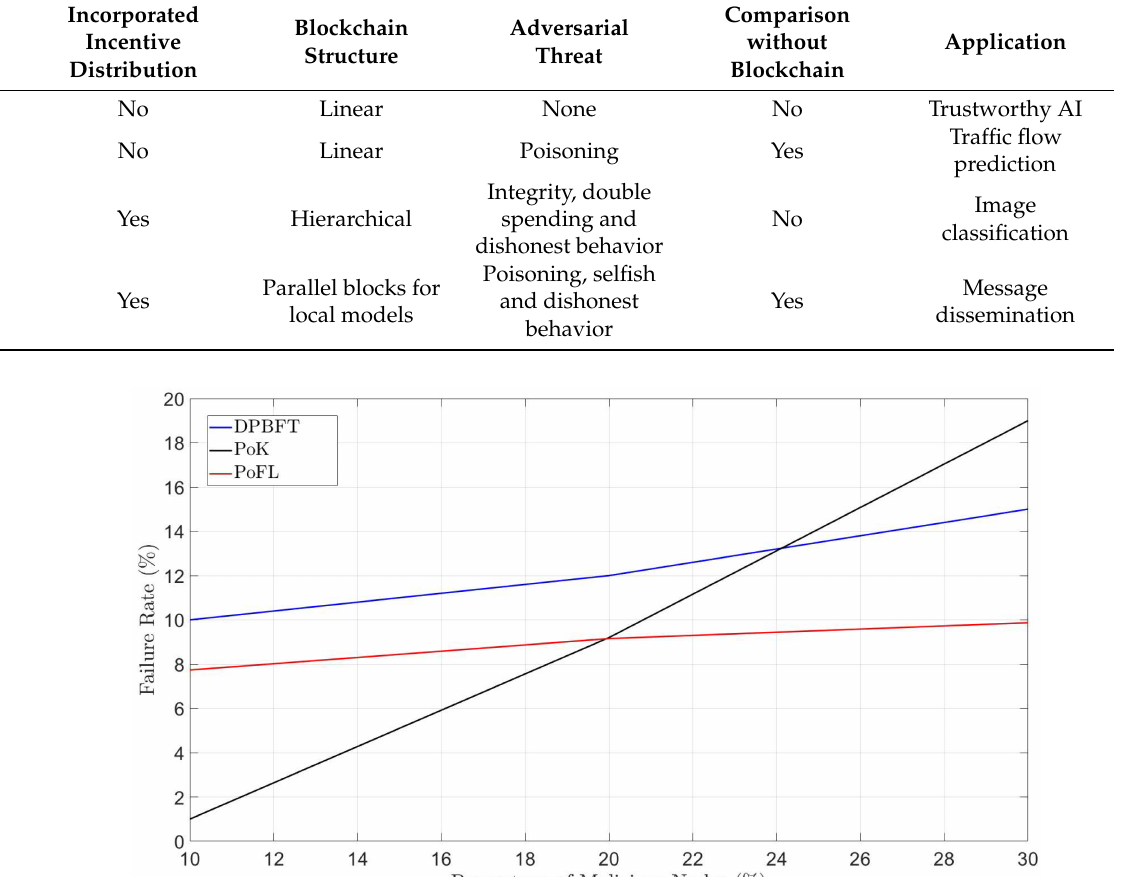
Figure 5. Failure rate in the presence of malicious